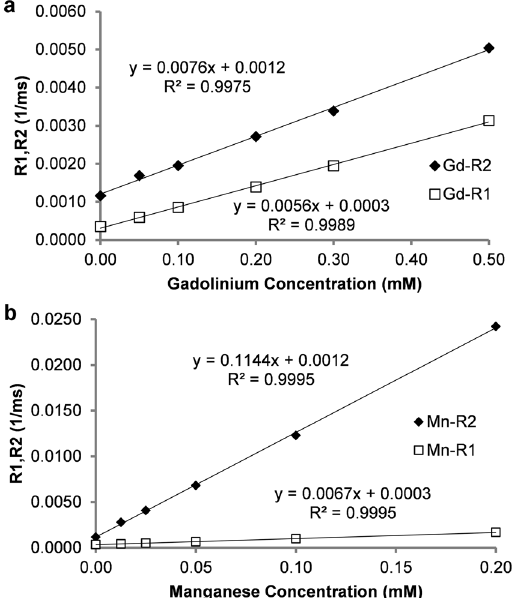
Figure 3. MRF-based relaxivity assessments for ( a ) gadolinium (Gd) and ( b ) manganese (Mn) contrast agents obtained on a 3 T MRI scanner using phantoms containing varying concentrations of a single contrast agent. Slopes of the fitted lines of R1, R2 vs. agent concentration (n = 6 for each agent) were used to determine the relaxivities (r 1 and r 2 ) of the two agents. Pearson correlations resulted in significant correlations of concentration vs. R1 and R2 for the two contrast agents (R 2 ≥ 0.997, two-tailed probability p <